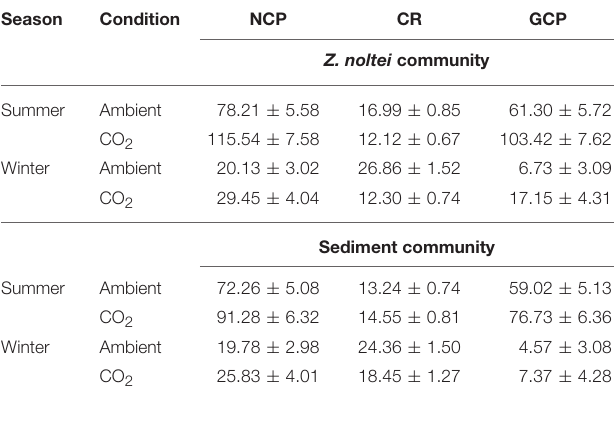
and unvegetated sediment community under ambient and CO 2 enriched conditions in summer and winter seasons.